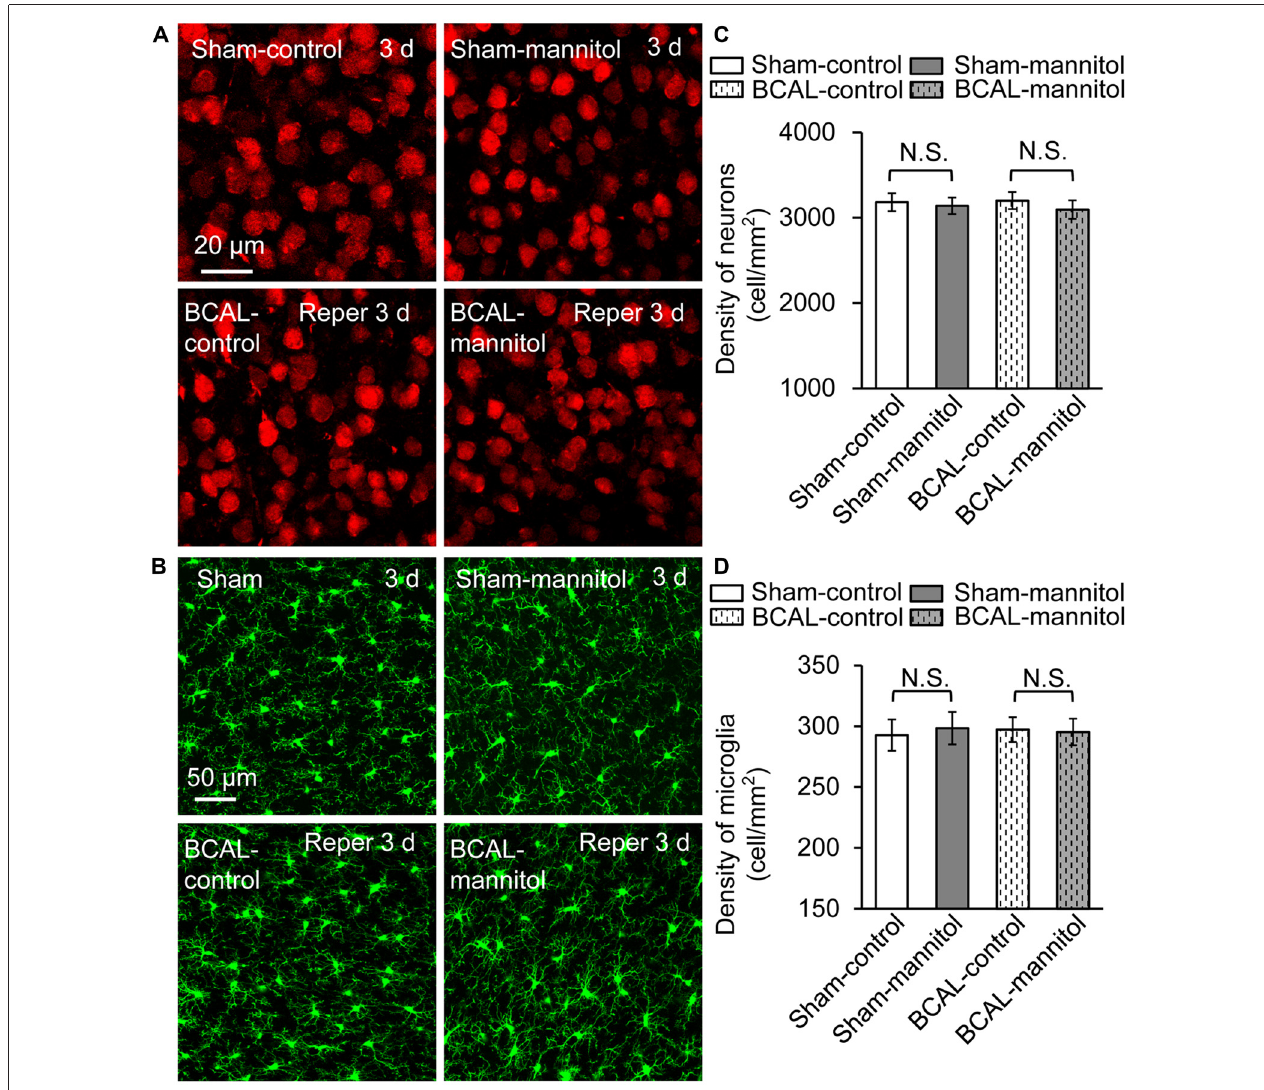
FIGURE 6 | Mannitol did not affect the densities of neurons or microglia after ischemia. (A) Representative confocal images of the neurons (red) in different groups. (B) Confocal images showing the morphology of microglia (green) in different groups. (C) Quantification of neuronal density showing that there is no significant difference in different groups ( n = 6 mice, each group. N.S., p > 0.05). (D) The density of microglia was not changed after transient ischemia and/or mannitol treatment ( n = 6 mice, each group. N.S., p >